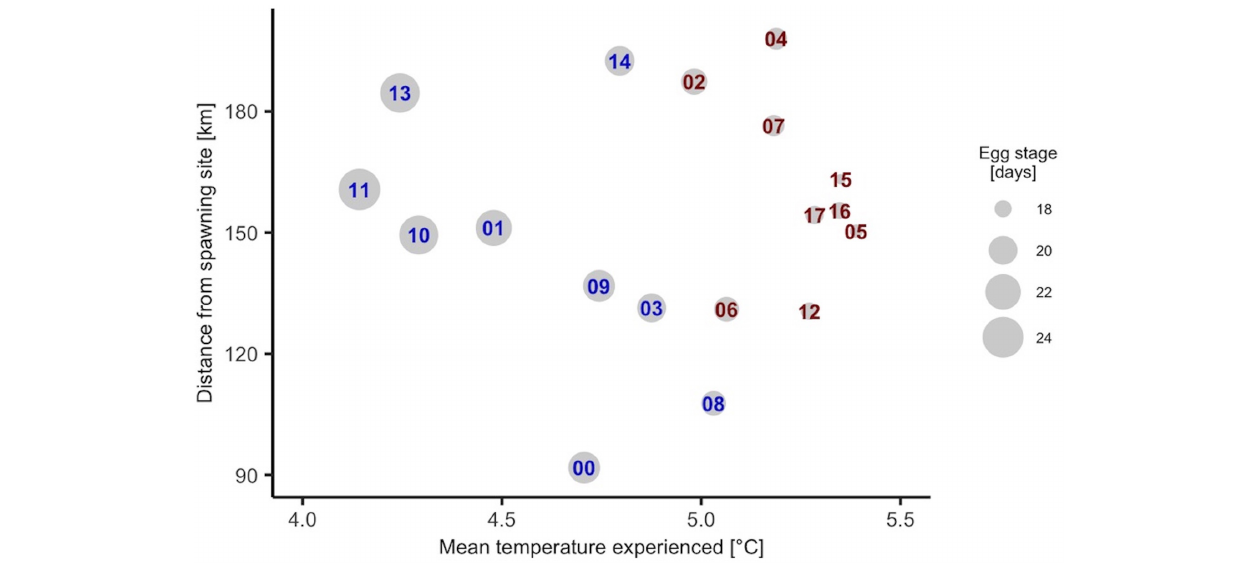
( ∼ 198 km), more than double the distance traveled in the year 2000 ( ∼ 91